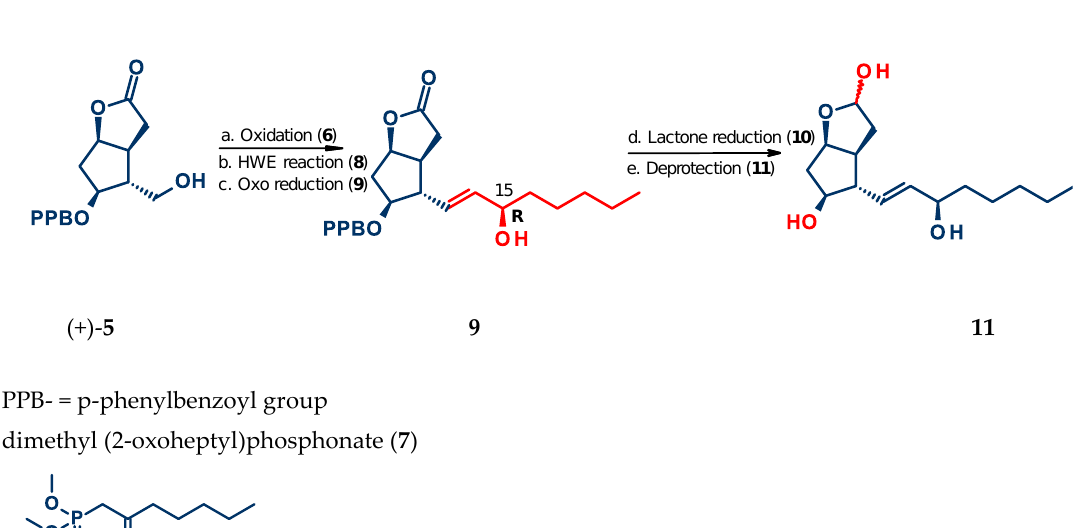
Scheme 4. Preparation of lactone (11) from ent -Corey lactone ( + )- 5 . ( a ) NaOCl, KBr, NaHCO3, TEMPO catalyst, dichloromethane, water, 0–10 ◦ C; ( b ) 7 , NaOH, dichloromethane, water, 0–10 ◦ C, crystallization from diisopropyl ether-hexane; ( c ) BH3-DMS, pyrocatechol, (S)-2-Me-CBS, THF, ( − 15)–( − 10) ◦ C; ( d ) DIBAL-H, THF, toluene, ( − 75)–( − 70) ◦ C, chromatography with toluene-EtOAc, crystallization